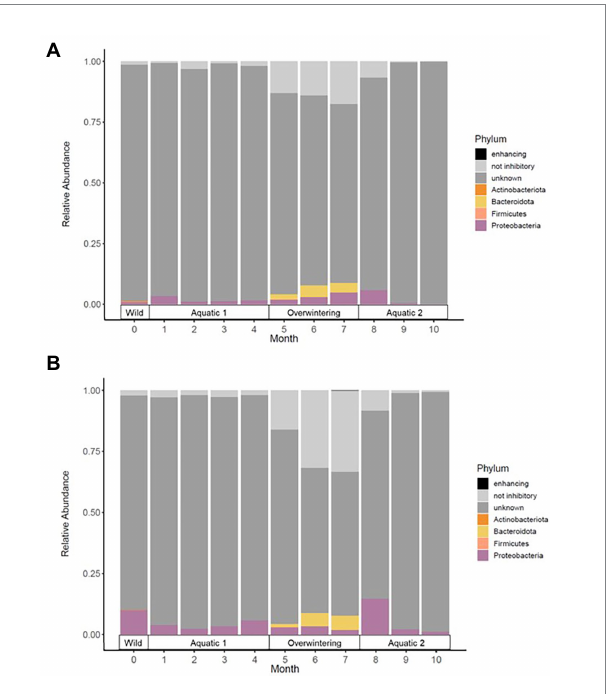
FIGURE 4 Mean relative abundance of phylotypes with known Bd -inhibitory activity (in color) in the skin microbiota of alpine (A) and palmate (B) newts, at the phylum level, across time of the experiment. Dominant phyla are identified in the legend. Phylotypes with no or with untested activity against the chytrid are in